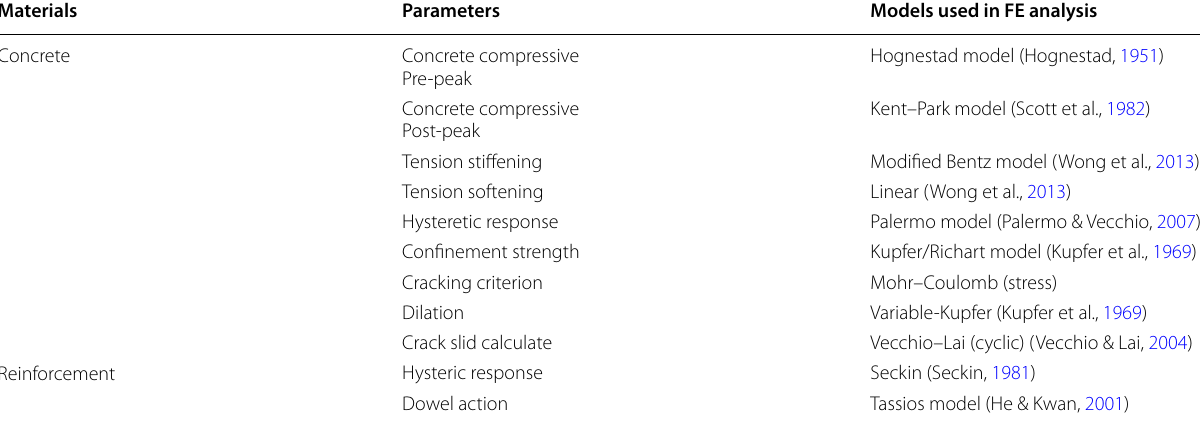
Table 3 Material constitutive models used in the RC wall